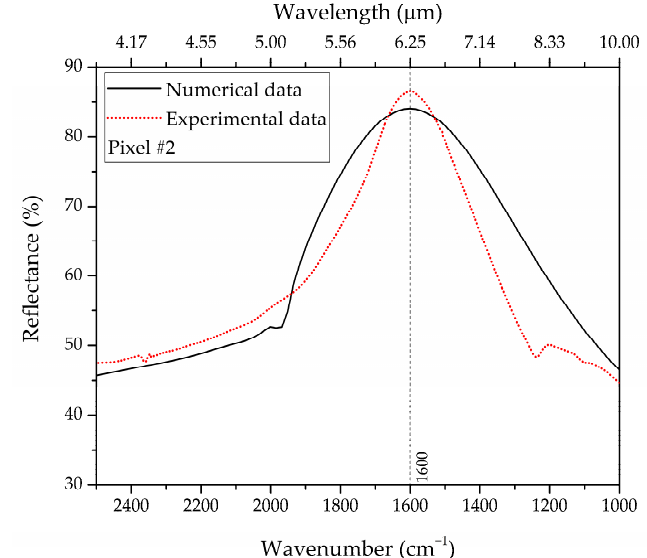
Figure 5. Comparison between numerical (black-solid curve) and experimental (red-dotted) reflectance responses pertaining to pixel #2 for naked NAs (no molecules adsorbed).